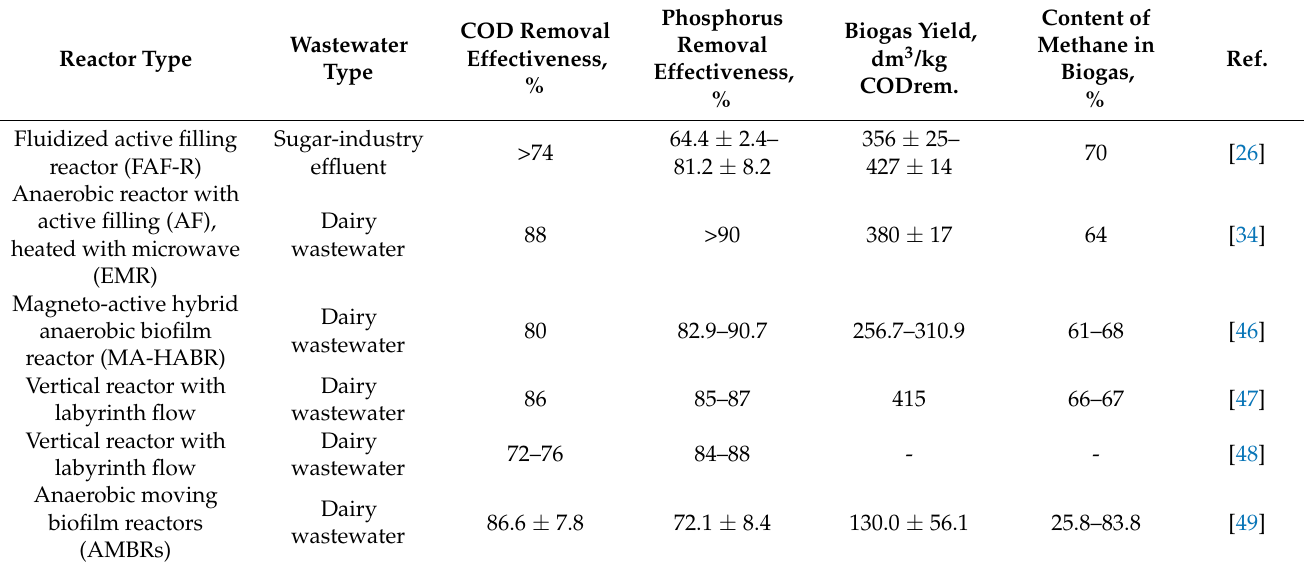
Table 3. Summary of research works verifying the technological performance of an active filling in anaerobic